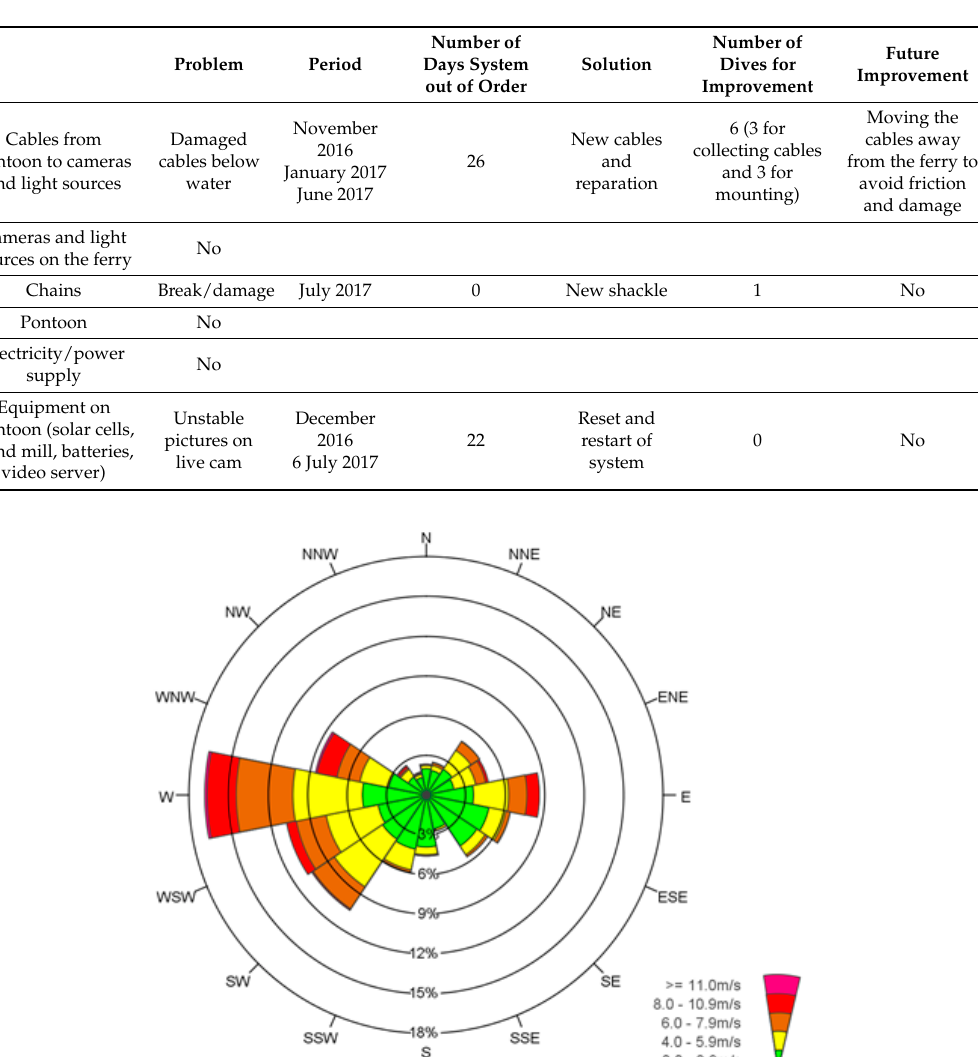
Table 1. Overview of the different parts of the system for live streaming and the observed problems the parts potentially have caused, number of days out of order, solution to the problem, number of dives used to repair, and future improvements.